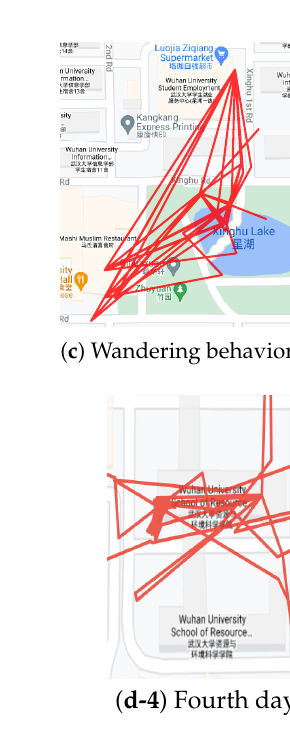
Figure 8. Examples of random, wandering, and scouting behavior identification.